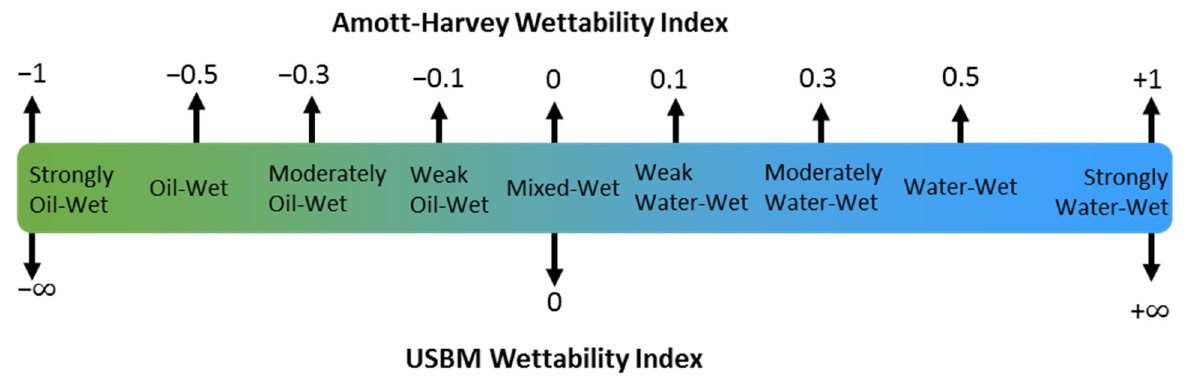
Figure 4. Graphical illustration of the integration of Amott–Harvey and USBM wettability index showing the different types of wetting conditions.